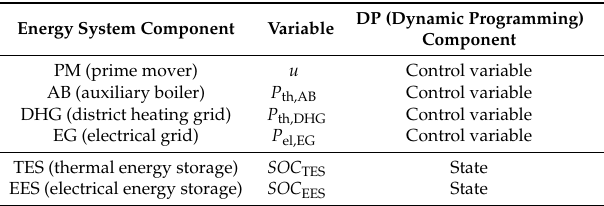
Table 1. Control variables and